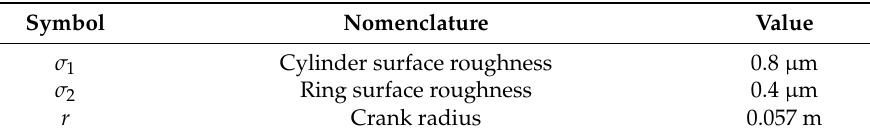
Table 1. Values of parameters for